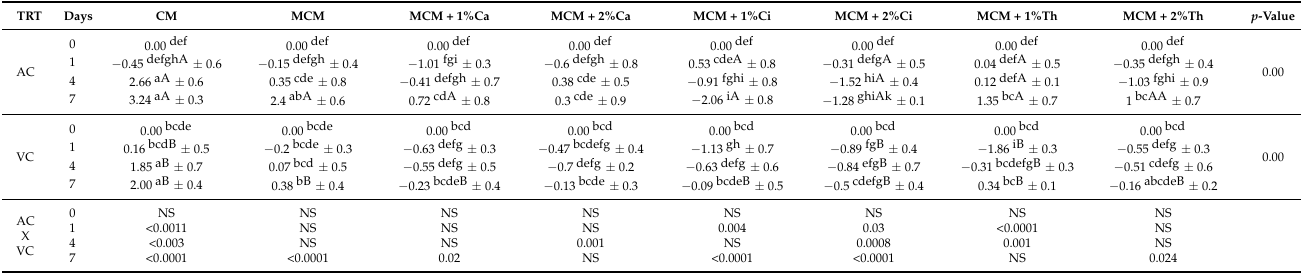
Table 6. Population changes of mesophilic lactic acid bacteria (log (N0/N) ± SD CFU/g) in marinated camel meat with essential oils under aerobic (AC) and vacuum (VC) conditions after storage at 10 ◦ C for 0, 1, 4 and 7 day.